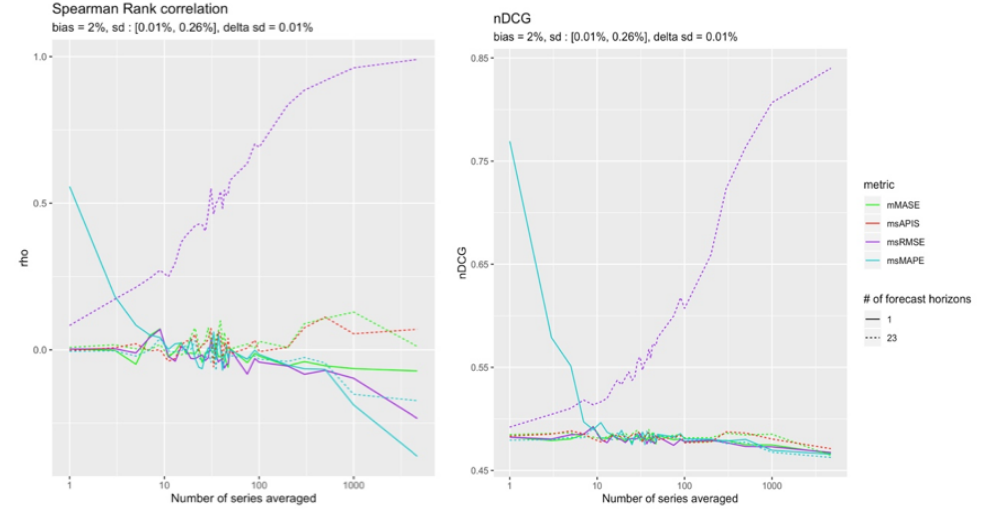
Figure 12. Spearman Rank correlation and nDCG for ( − + − )